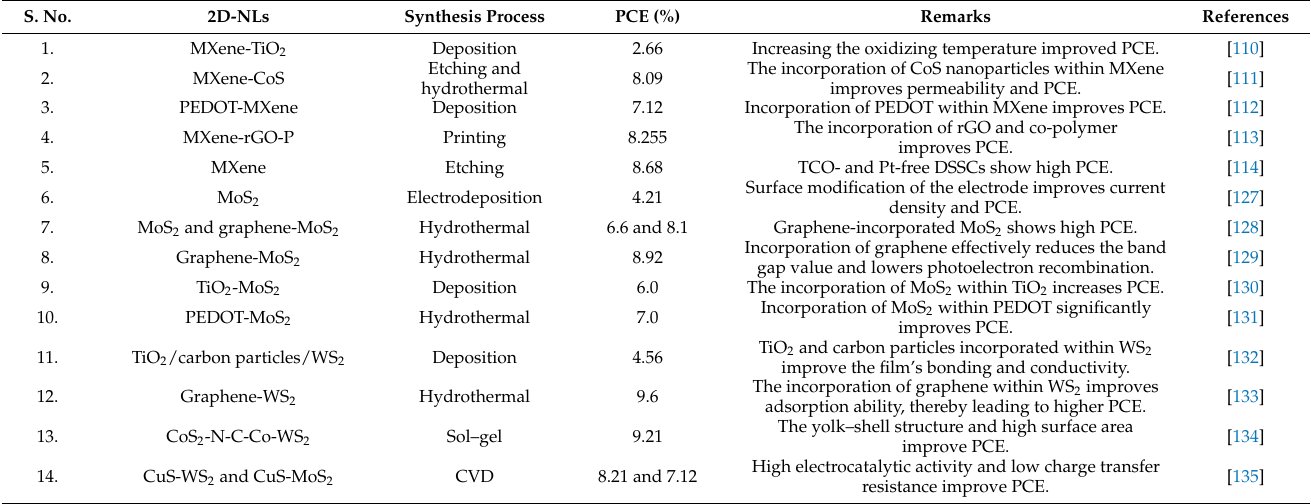
Table 3. Different 2D-NLs, their hybrid material-based DSSCs, and